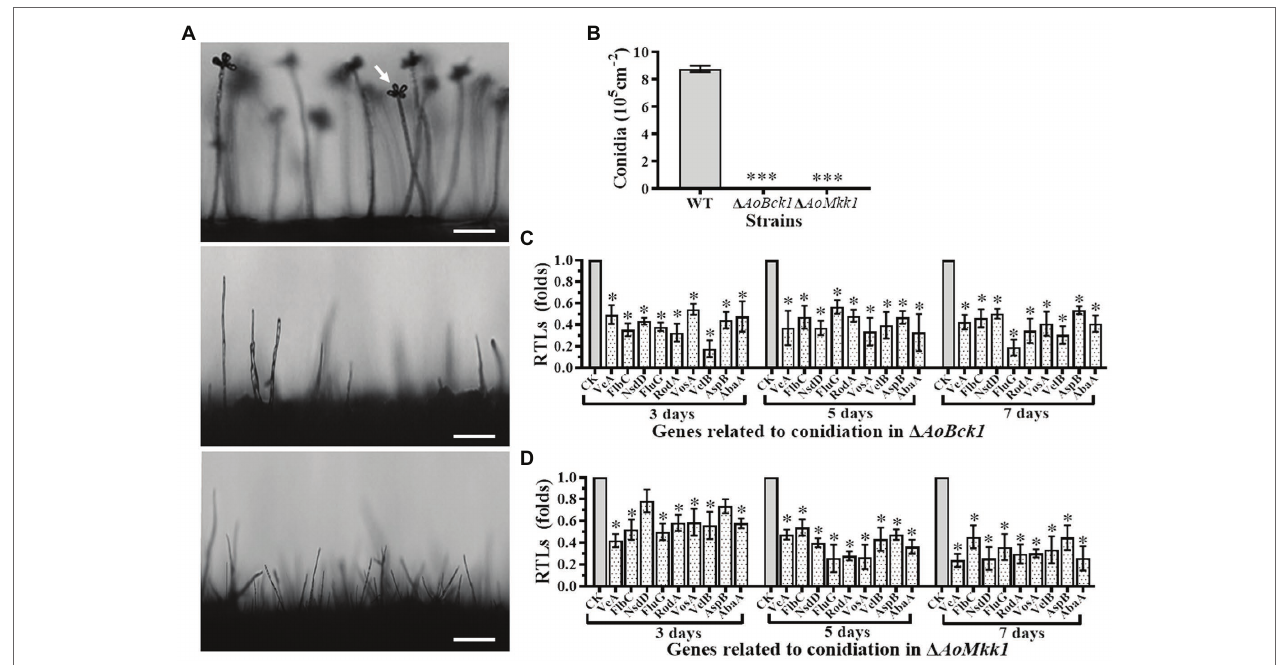
FIGURE 3 | Comparison of conidiation and transcript of sporulation-related genes between the WT and mutants. (A) Comparison of conidiophore and sporulation the WT and mutants on CMY medium. White arrows: conidium; Bar = 10 μ m. (B) Conidial yields in the WT vs. Δ AoBck1 and Δ AoMkk1 mutants. Three asterisks: very significant difference between mutant and the WT ( p < 0.001). (C) Relative transcript levels (RTLs) of selected genes involved in conidiation of the WT and Δ AoBck1 mutants at different time points. (D) RTLs of selected genes involved in conidiation of the WT and Δ AoMkk1 mutants at different time points. An asterisk indicates a significant difference between the mutants and the WT strain ( p < 0.05). CK under given conditions, using CK with an RTL of 1 as the standard, statistical analysis was performed on the RTL of each gene in each mutant and the WT strain. An asterisk indicates a significant difference compared to the WT ( p <